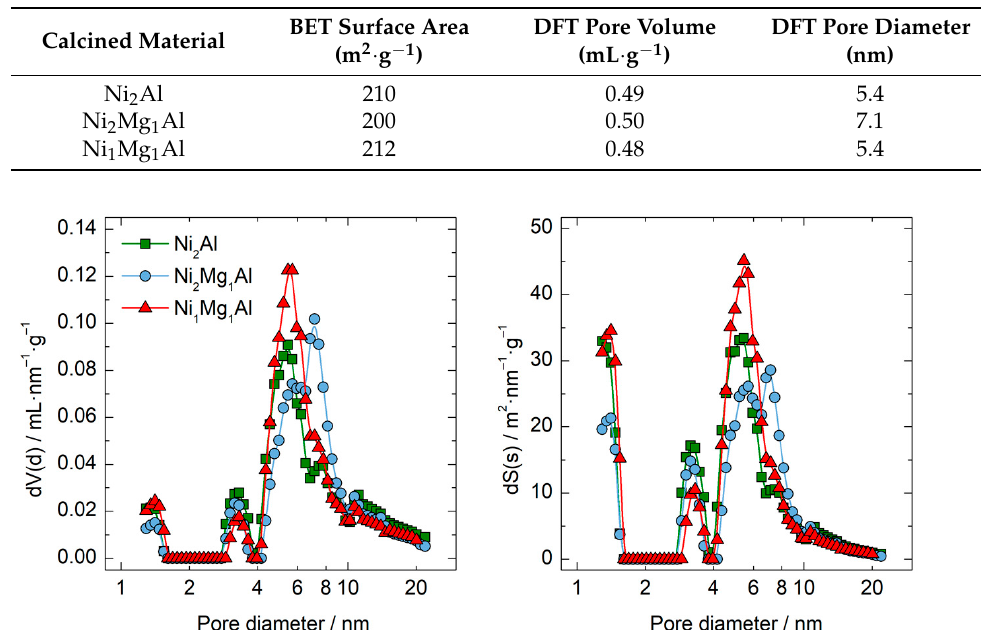
Figure 2. Pore volume ( left ) and surface ( right ) distributions of the LDH precursors calcined at 400 °C for 4 h and determined with the DFT model.